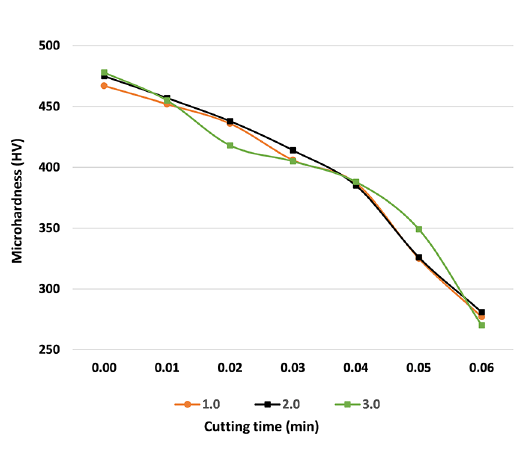
Figure 9. Evolution of microhardness of the machined surface in depth